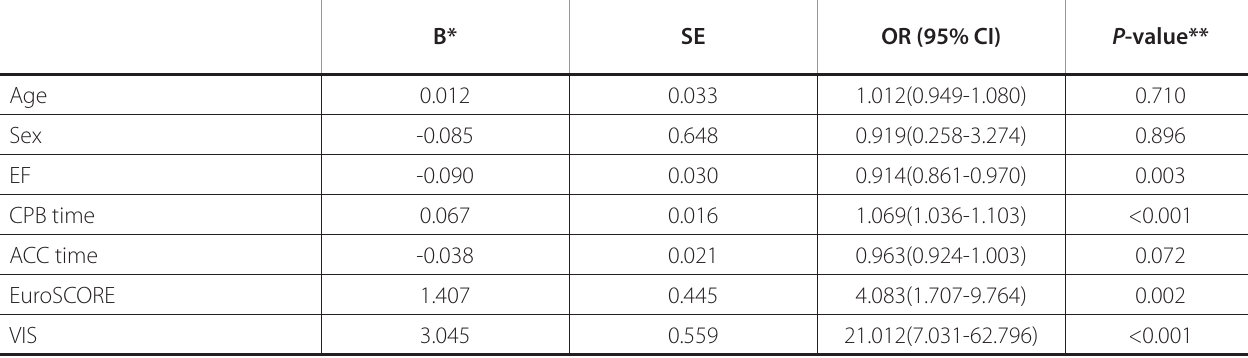
Table 3 . Calculation of independent risk factors for development of combined morbidity and